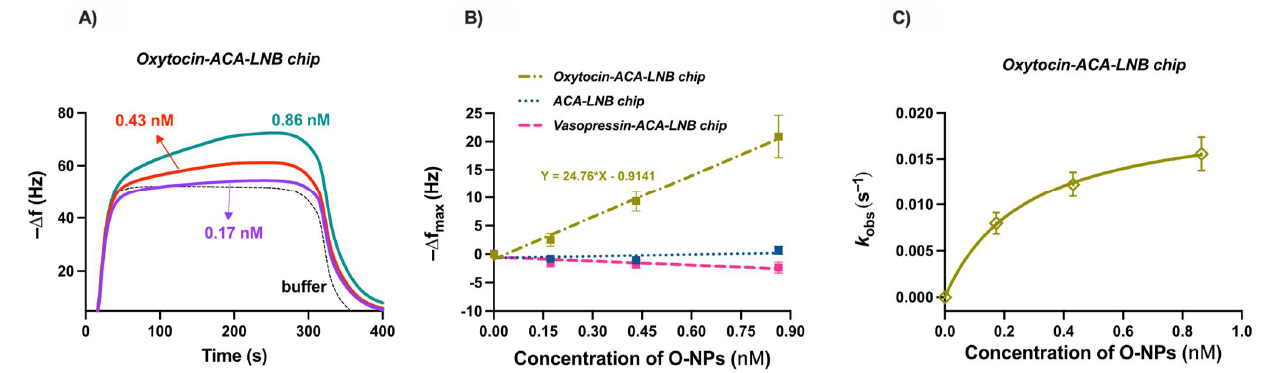
Figure 7. QCM trace during immobilization of oxytocin on LNB carboxyl chip. ( A ) Carboxyl activation of LNB-chip by EDC/Sulfo-NHS; ( B ) ACA immobilization (2 injections); ( C ) deactivation by ethanolamine; ( D ) ACA activation by EDC/Sulfo-NHS; ( E ) oxytocin immobilization (three injections); ( F ) deactivation by ethanolamine.